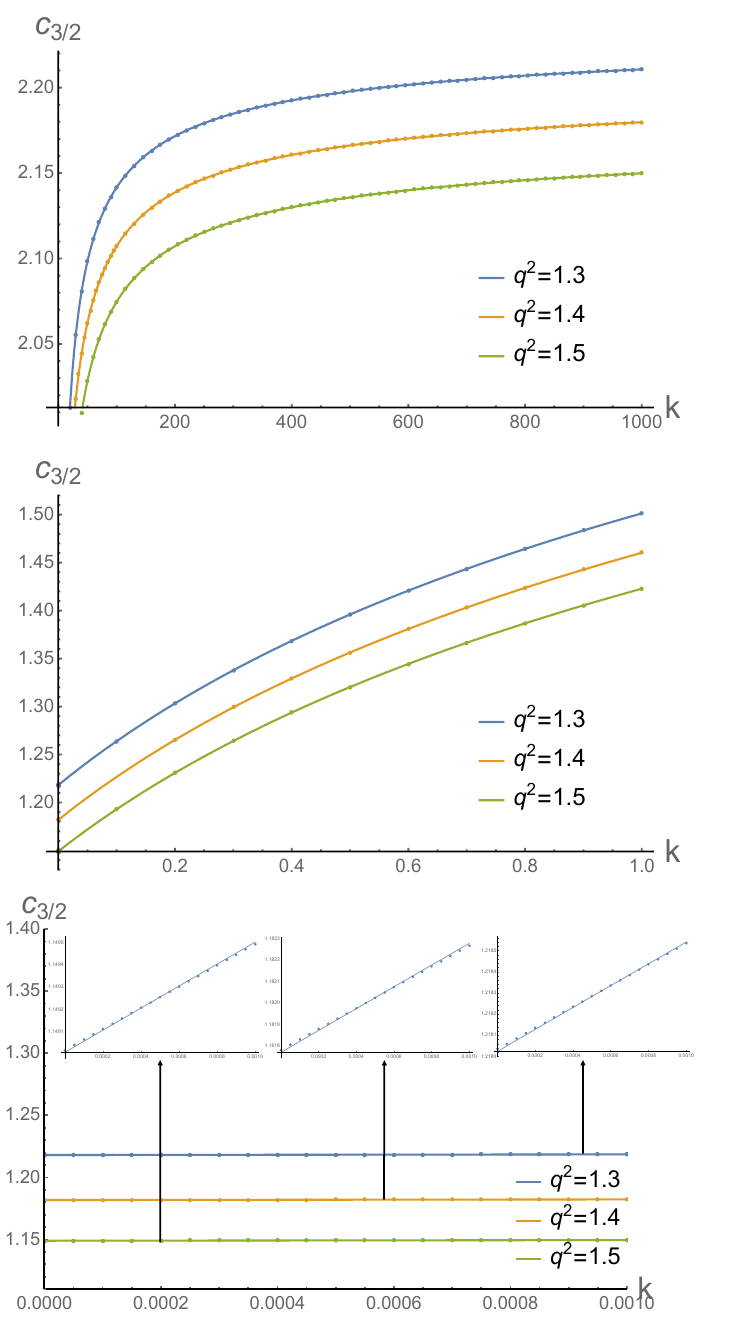
coefficient as a function of k is plotted in the large, middle and small k regions Figure 1 . The c 3 / 2 for different q 2 . The dots are the numerical data and lines are the analytical function (3.1), and they have perfect match even though the data runs over 7 orders of magnitude. Note that the linear dependence at small k appears to be horizontal when plotted together, actually the slops are all about 0 . 5 , as can be seen in the magnified